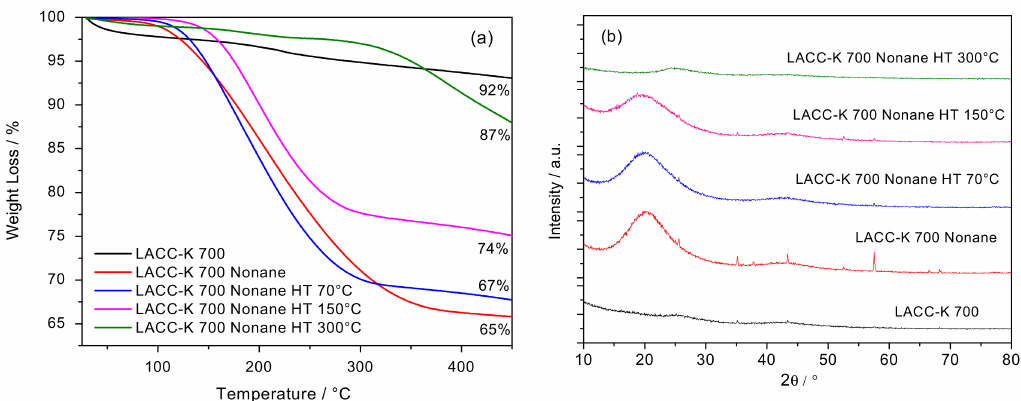
Figure 2. ( a ) Thermogravimetric analysis of sample LACC-K 700 before and after exposure to n-nonane, and LACC-K 700 sample after di ff erent thermal treatments under inert atmosphere; ( b ) XRD pattern for the samples